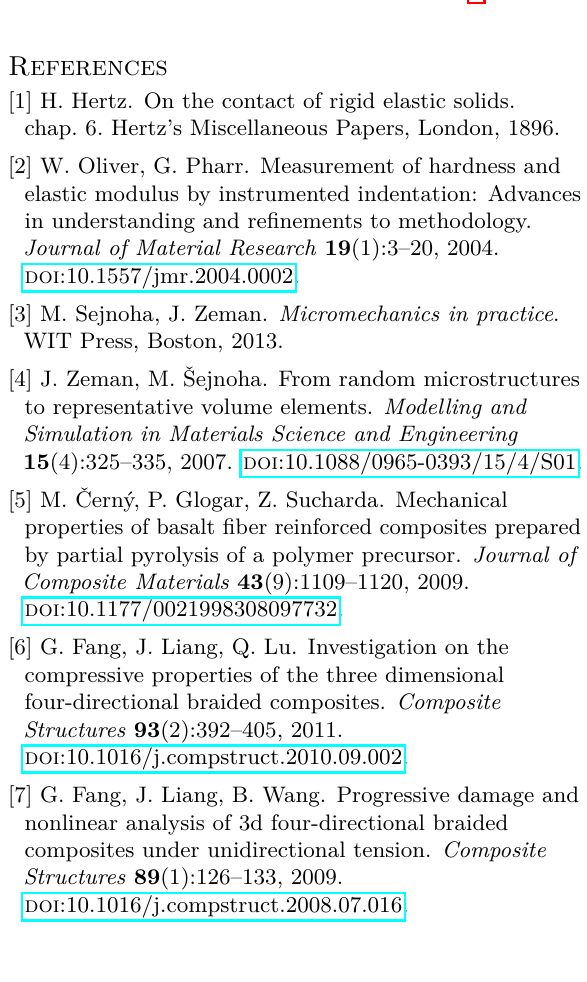
Figure 8. Damage evolution in the matrix corresponding to the marked numbered points in Fig.